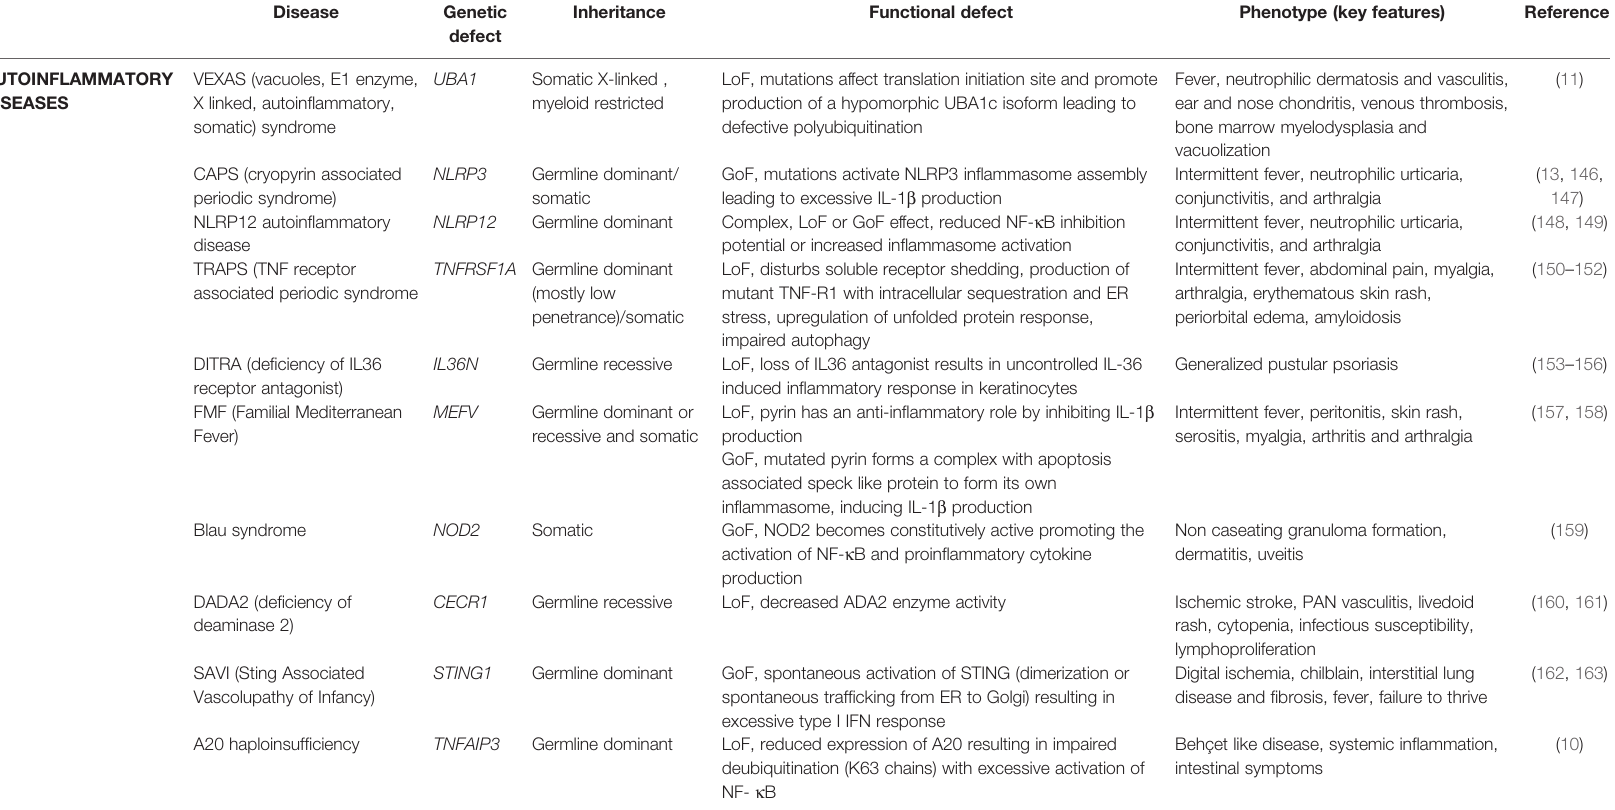
TABLE 6 | Genes associated with adult-onset autoin fl ammatory